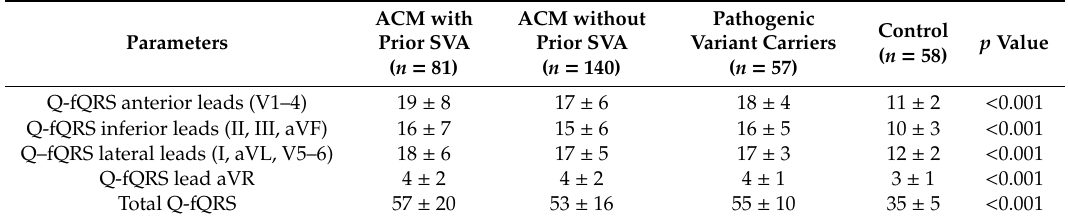
Table 2. Fragmentation of the QRS complex.